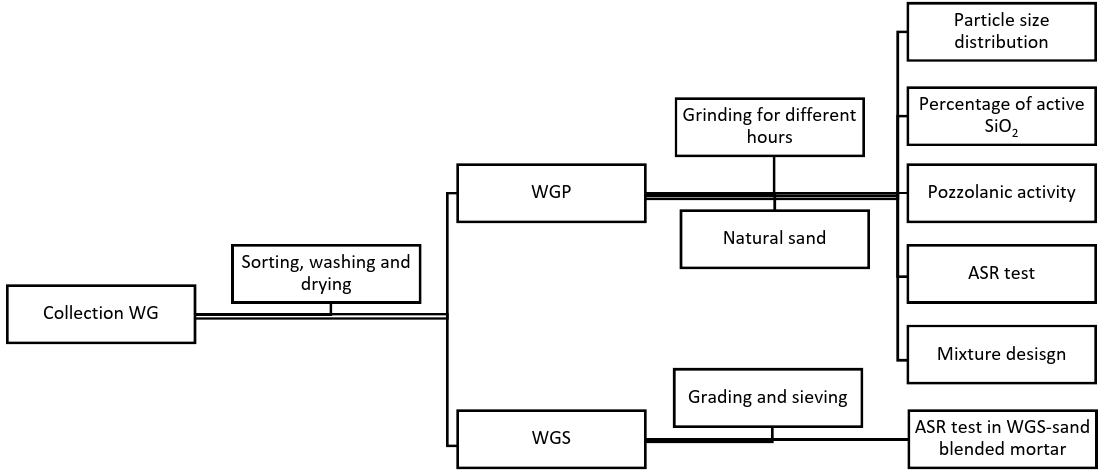
Figure 1. The research framework. WGS, waste glass sand; WGP, waste glass powder; ASR, alkali–silica reaction.